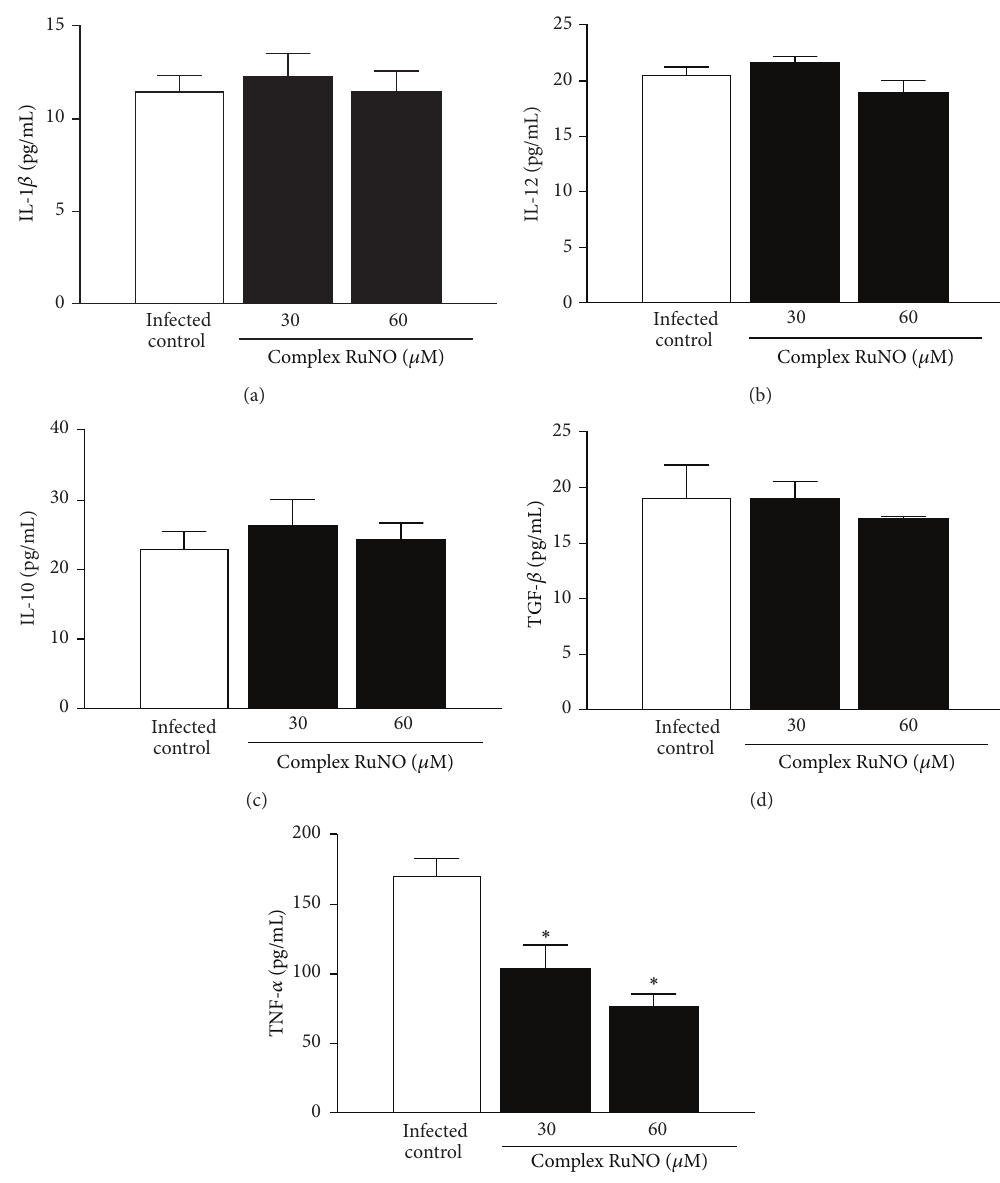
Figure 2: In vitro production of cytokines by peritoneal macrophages infected and then treated with RuNO complex (30 and 60 𝜇 M). (a) IL-1 𝛽 , (b) IL-12, (c) IL-10, (d) TGF- 𝛽 , and (e) TNF- 𝛼 . [Values represent the mean ± SEM of three independent experiments ( 𝑃 < 0.05 ). ∗ Significantly different from